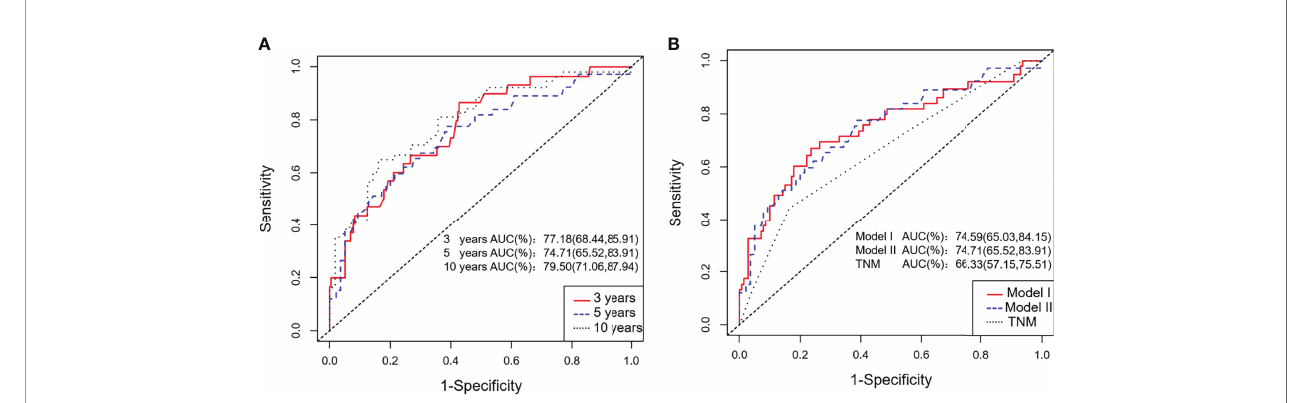
FIGURE 4 | ROC curves for the training cohort. (A) The 3-, 5-, and 10-year ROC curves of the training cohort; (B) ROC curves of Nomogram Model I, Model II and the TNM staging system for the training cohort.